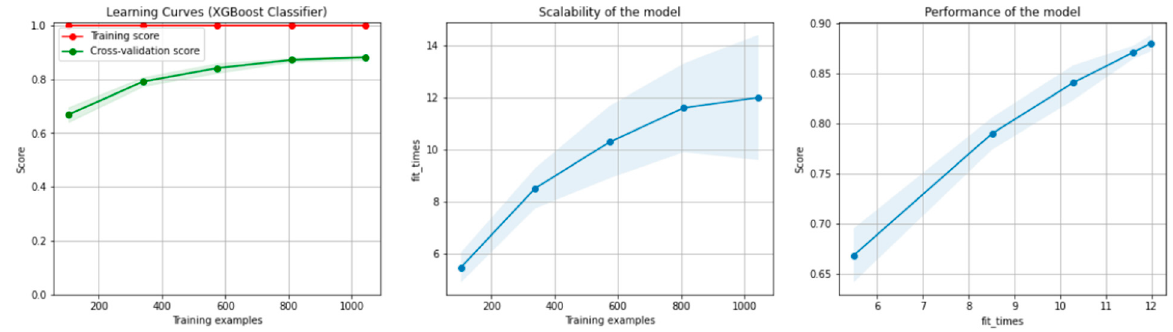
Figure 8. Learning curves, model scalability and model performance for the Gradient Boosting Tree algorithm, for the non-overlapping dataset.